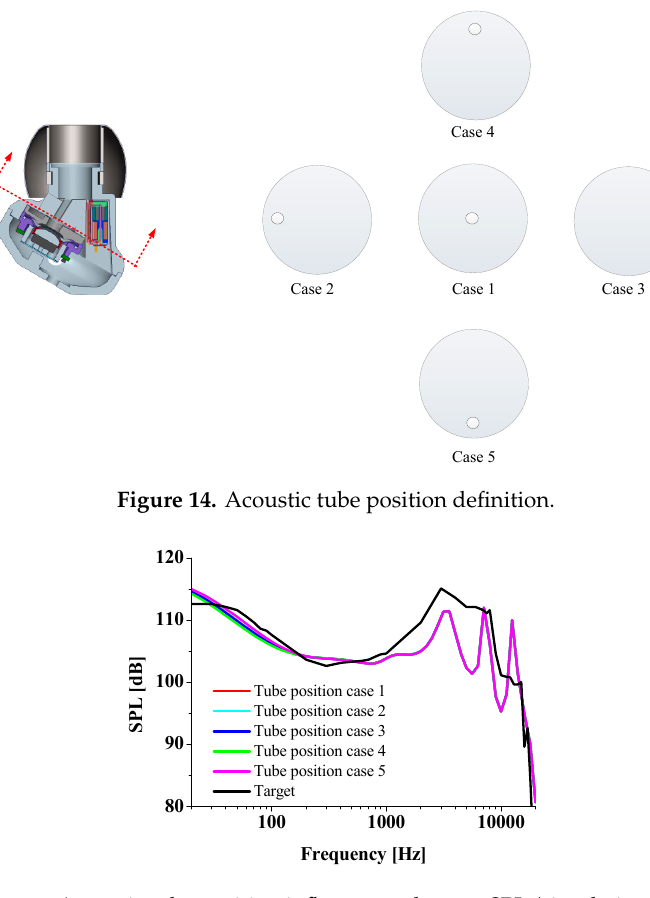
Figure 16. Acoustic tube diameter definition. 100